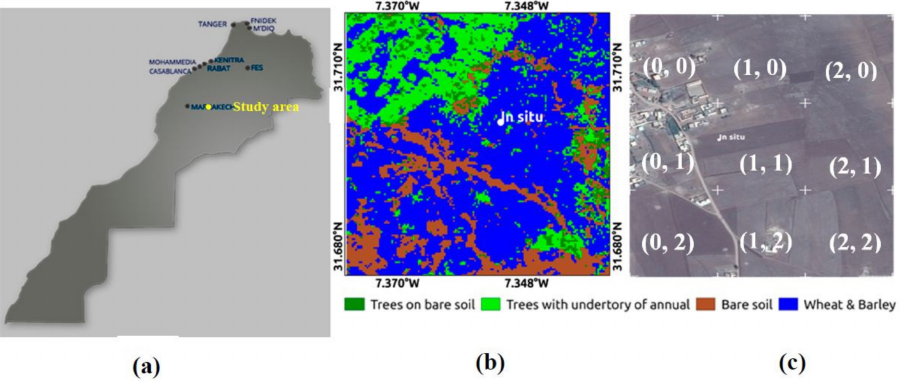
Figure 1. ( a ) The study area located at the east of Marrakech city, Morocco; ( b ) land cover/land use map of the study area (5 km 2 ); and ( c ) Google map of nine pixels (100 m resolution) of the study area where pixel (1, 1) includes the station for the in situ